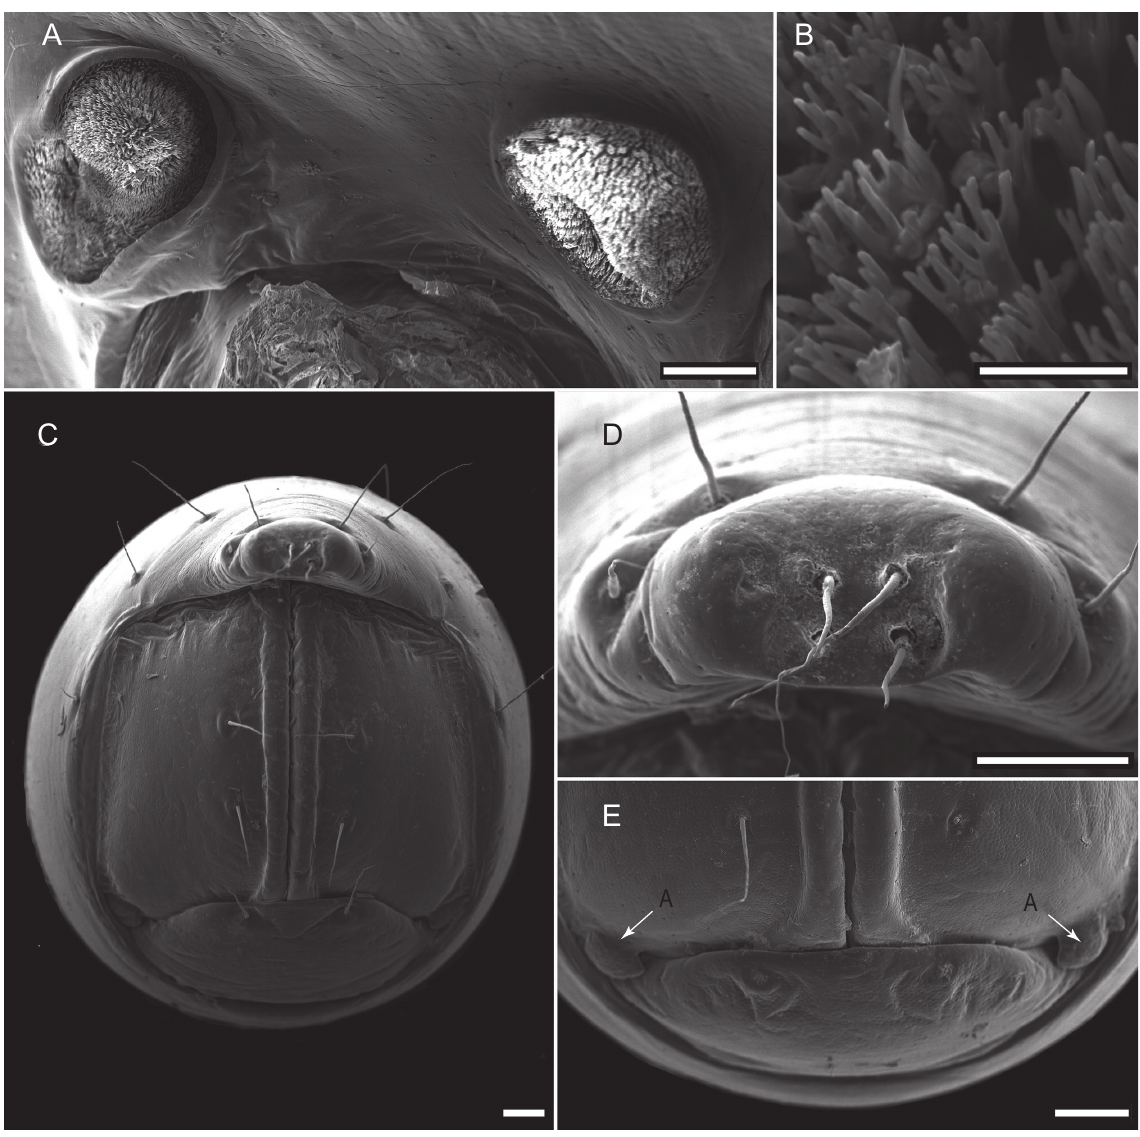
Fig. 4. Pogonosternum montanum Decker, sp. nov. A – B . Spiracles on left midbody ring, lateral view (AMS KS 106884). A . Overview of anterior (left) and posterior (right) spiracles. B . Spiracular filter of anterior spiracle. C–E . Telson, posterior view (NMV KS106884). C . Telson overview. D . Spinnerets. E . Anal valves and hypoproct. Abbreviations: A = ventrolateral hook-like process. Scale bars: A = 50 µm, B = 5 µm, C, D, E = 0.1